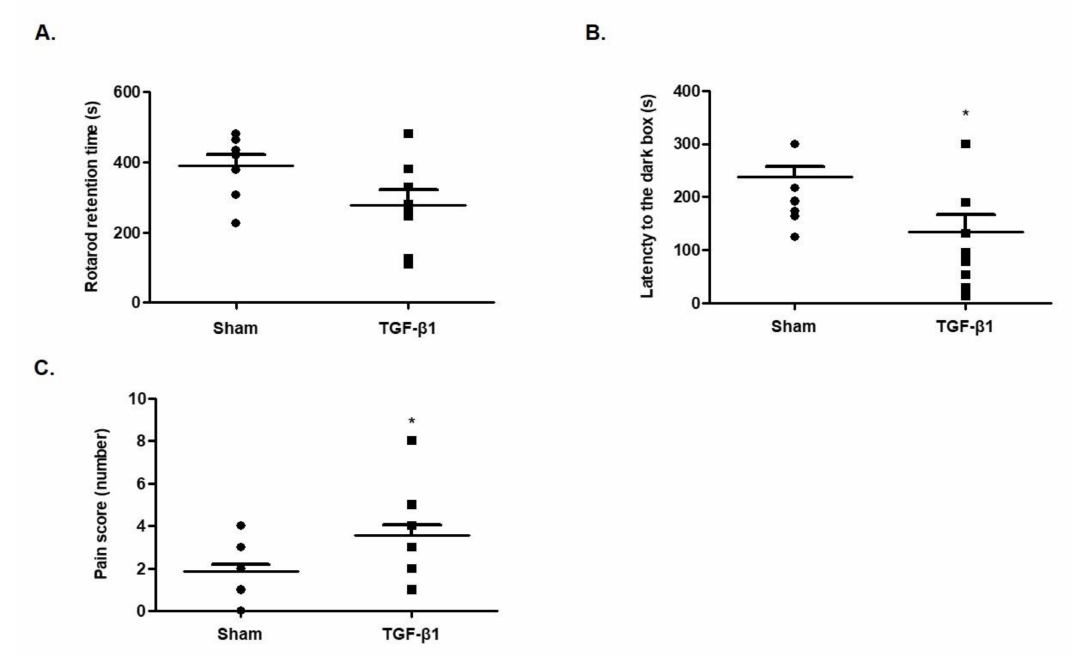
Figure 2. Effects of TGF- β 1 on motor function, learning memory and allodynia. ( A ) C57BL/6 mice were intracranially injected with TGF- β 1 and a rotarod test was performed to measure retention time on a rotating rod. ( B ) The latency time to enter the dark compartment from the bright compartment using the passive avoidance test. ( C ) The sensitivity to pain was measured by counting the number of evasion behaviors from hair stimulation on hind paw in the von Frey test. Data are presented as mean ± SEM (N = 8–10). * p < 0.05 compared with the sham group.